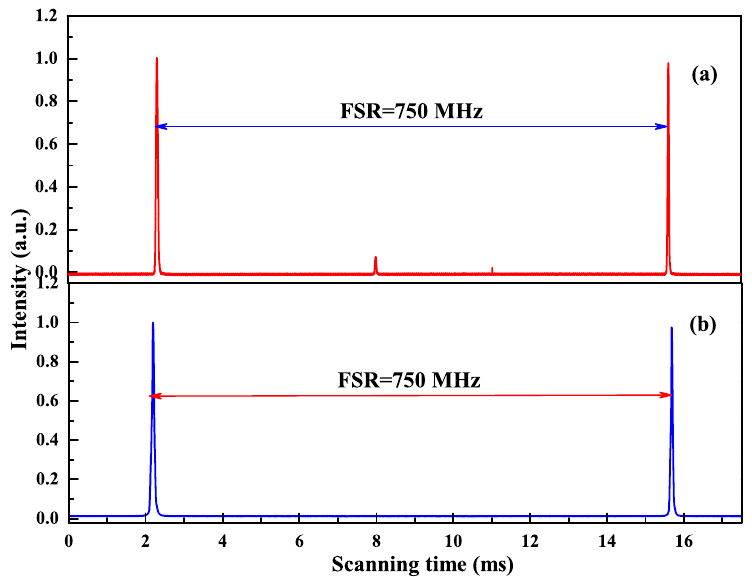
Figure 3. Longitudinal-mode structure of the laser ( a ) without and ( b ) with the nonlinear crystal LBO [21]. Reprinted with permission from [21] c (cid:13) The Optical